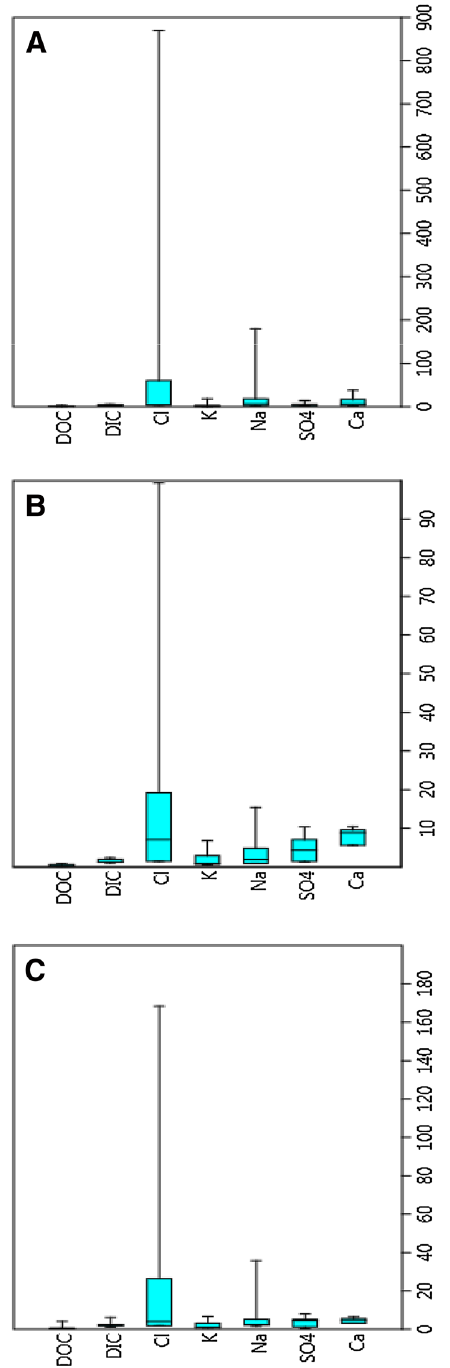
Fig. 3 Box-plot of various ions for a PRM, b MON and c